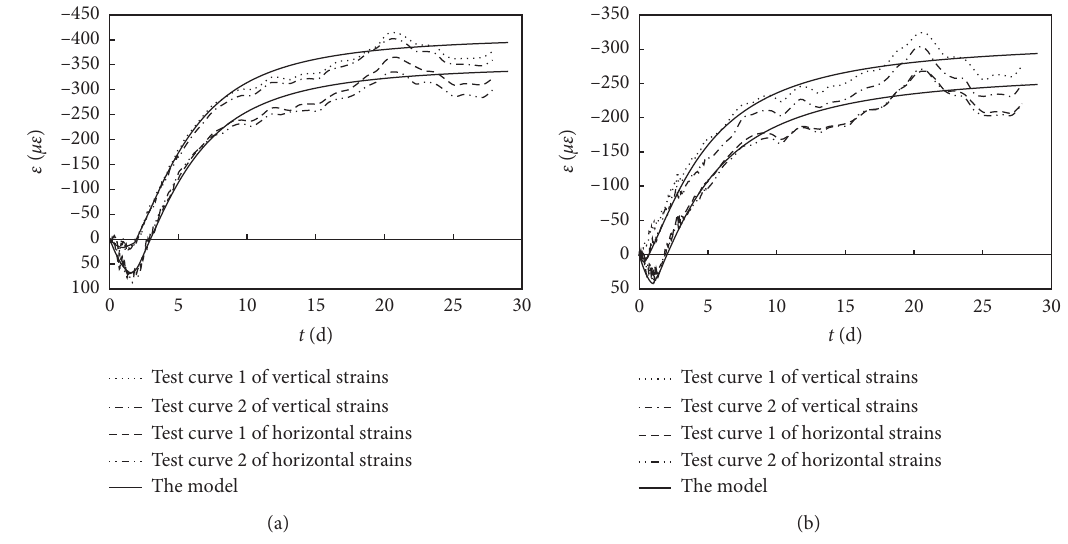
Figure 9: Comparisons between the calculation model and test curves. (a) SYZ-1 column. (b) SYZ-2 column. Table 5: Maximum values of expansion and shrinkage strains of the core concrete. Type of steel tube